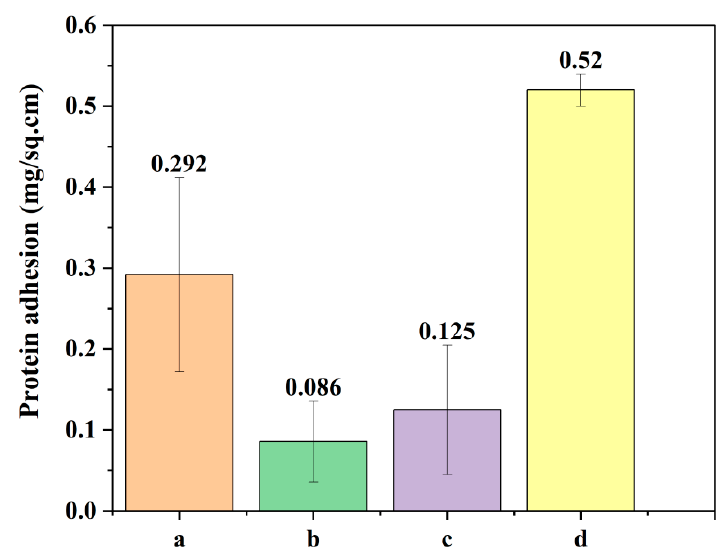
Figure 17. Protein adhesion test: (a) PLA, (b) PEG, (c) PLA-PEG, and (d) PLA-PEG-heparin.